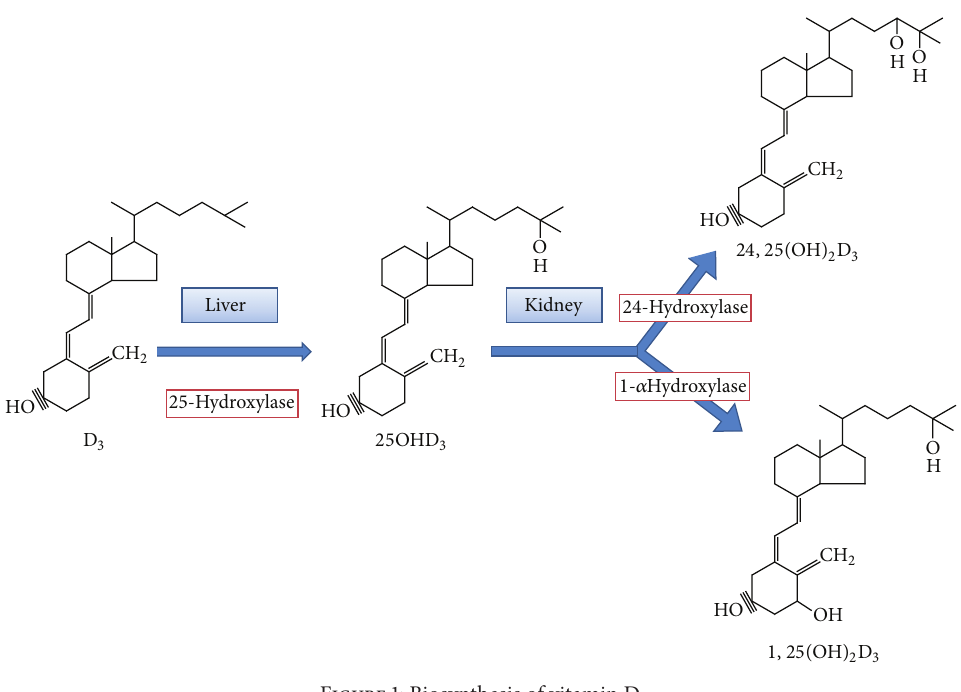
Figure 1: Biosynthesis of vitamin D.